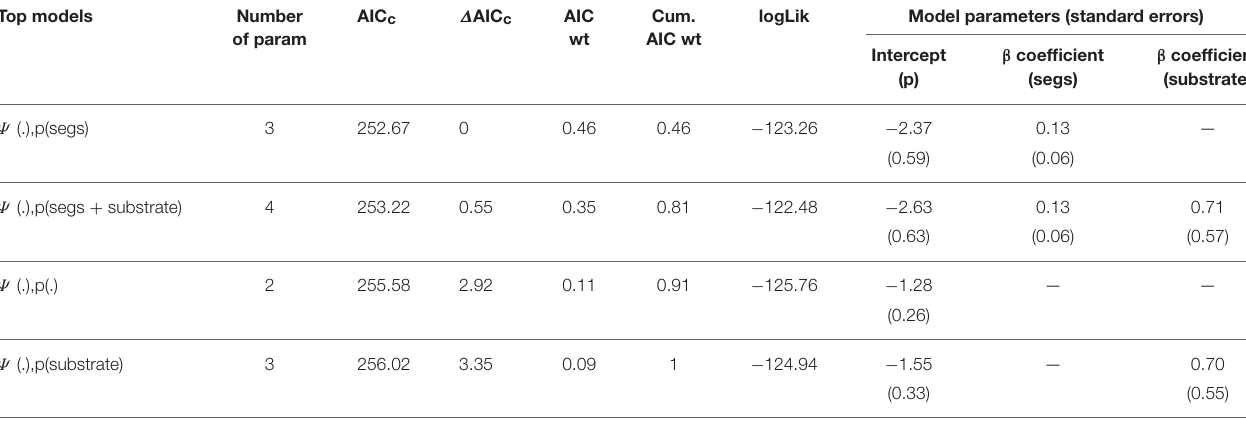
TABLE 2 | Model selection procedure for covariates associated with detection (p) of lions in WAP. Top models